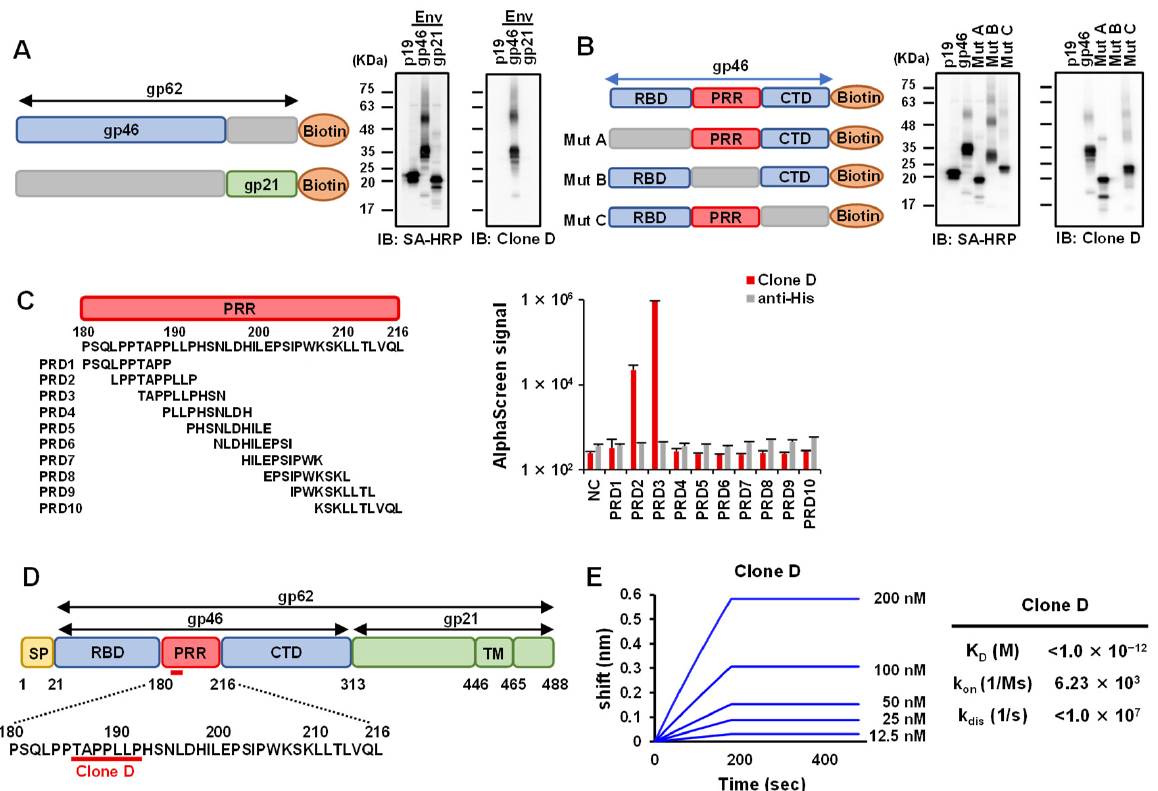
Figure 2. Epitope mapping and affinity measurement of mAb Clone D: ( A ) deletion mutants of HTLV-1 Env gp62 were produced using the wheat germ cell-free protein synthesis system. Reactivity of mAb Clone D to two HTLV-1 Env mutants (gp46 and gp21) was assessed by immunoblotting. Streptavidin (SA)-HRP was used as a positive control. The HTLV-1 gag protein, p19, was used as a negative control; ( B ) epitope mapping of three gp46 mutants, including Mut A ( ∆ RBD), Mut B ( ∆ PRR), and Mut C ( ∆ CTD); ( C ) ten N-termed biotinylated peptides (PRD1–PRD10) were used in the AlphaScreen assay (left). The results of the AlphaScreen assay for mAb Clone D are shown to the right. The anti-His mAb was used as a negative control. NC = Biotinylated dihydrofolate reductase (DHFR) used as a peptide negative control; ( D ) an epitope map of HTLV-1 Env gp62, showing the mAb Clone D recognition site (red line). SP = signal peptide; RBD = receptor-binding domain; PRR = proline-rich region; CTD = C-terminal domain; TM = transmembrane region; ( E ) the K D , k on , and k dis values of mAb Clone D determined using Bio-Layer interferometry.